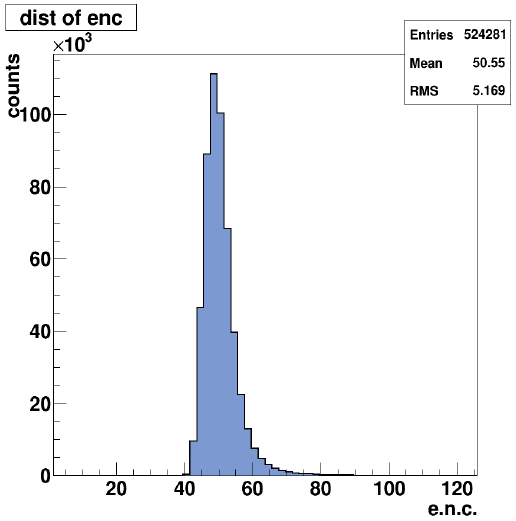
Figure 21. Distribution of the rms noise (in electrons) for all the pixels of a sample module. An average value of 50.5e.n.c. is